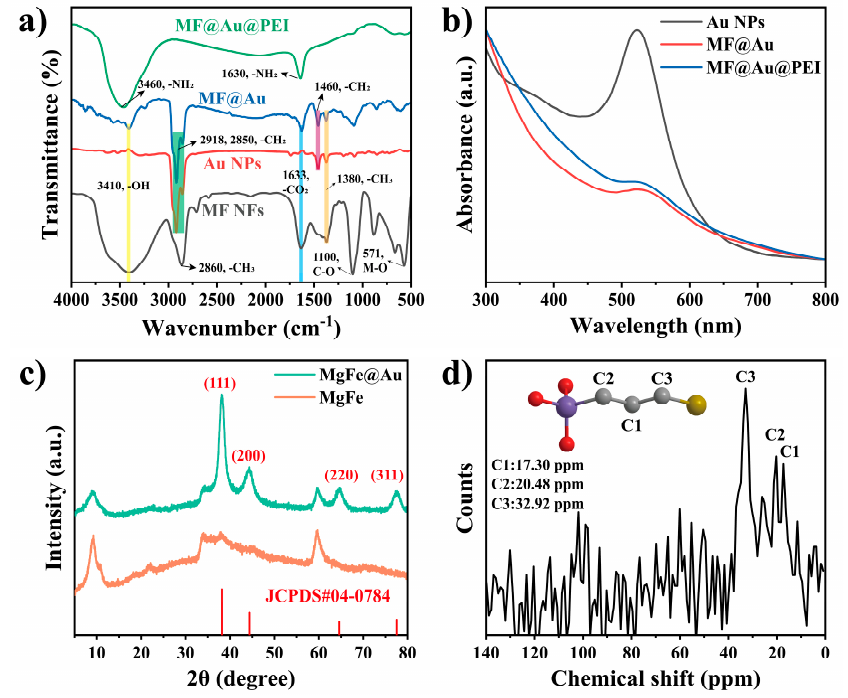
Figure 3. ( a ) FT-IR spectra of MF NFs, Au NPs, MF@Au NFs, and MF@Au@PEI NFs. ( b ) UV-vis absorption spectra of Au NPs, MF@Au NFs, and MF@Au@PEI NFs. ( c ) The XRD patterns of MF